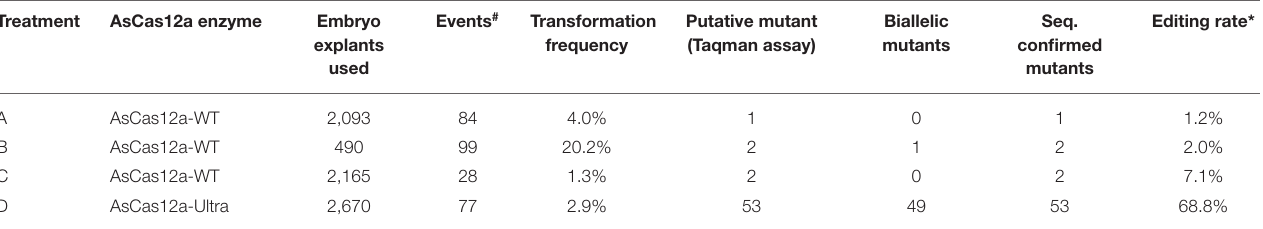
TABLE 3 | Targeted mutagenesis of Bx9 target Bx9TS1 with ribonucleoprotein (RNP) complex of two versions of AsCas12a in maize co-delivered with PMI selectable marker gene vector 12672. Treatment